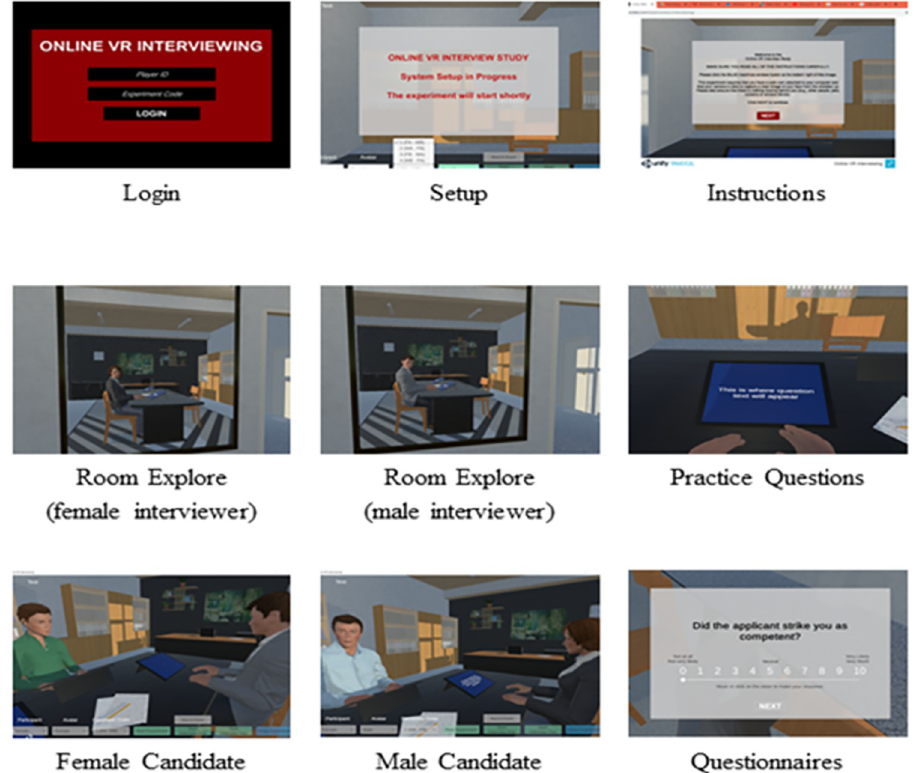
Fig 1. Virtual scenes. Visual still screen captures illustrating key study tasks undertaken in the virtual environment. Images are presented in sequence from top left to bottom